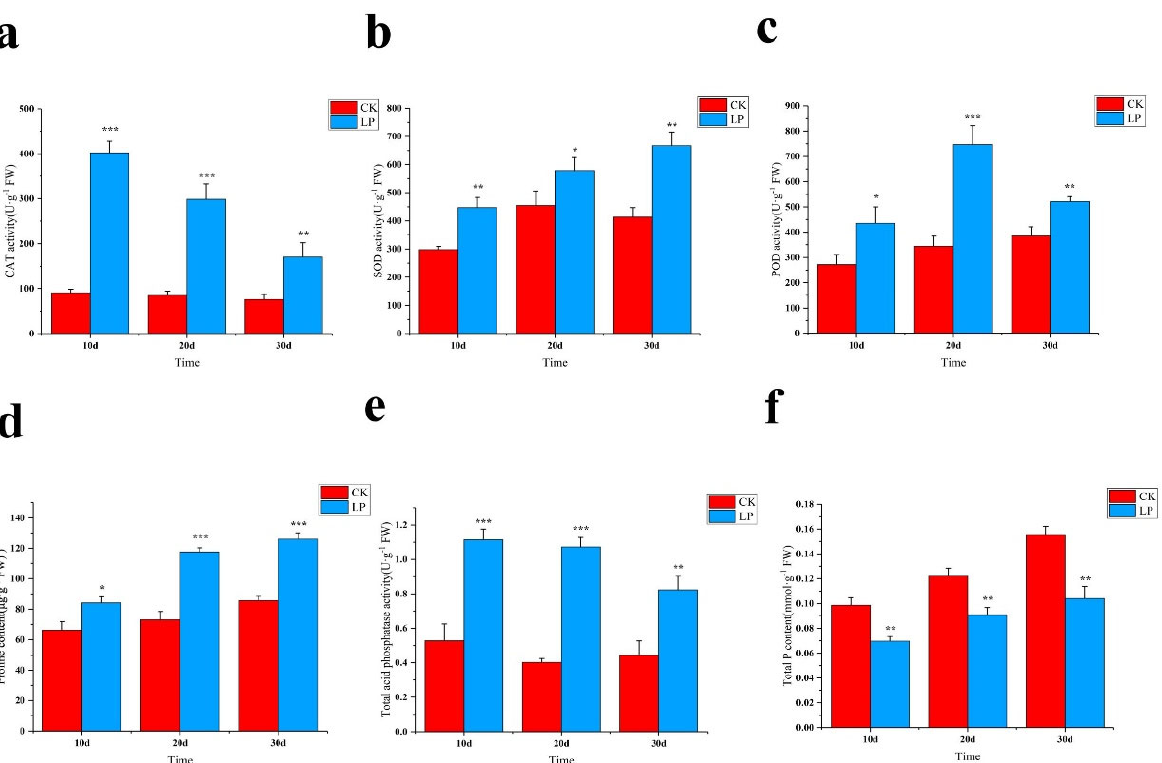
Figure 3. The changes of M. mandshurica leaves enzyme activity to low − Pi treatment. ( a ) CAT content, ( b ) SOD content, ( c ) POD content, ( d ) Proline content, ( e ) Acid phosphatase content, ( f ) Total phos- phorus content. According to the Tukey’s test, *** p < 0.01; ** p < 0.01 − 0.05; * p < 0. 1 − 0.05. The x − axis represents the processing time, and the y − axis represents the content of the measurement index.